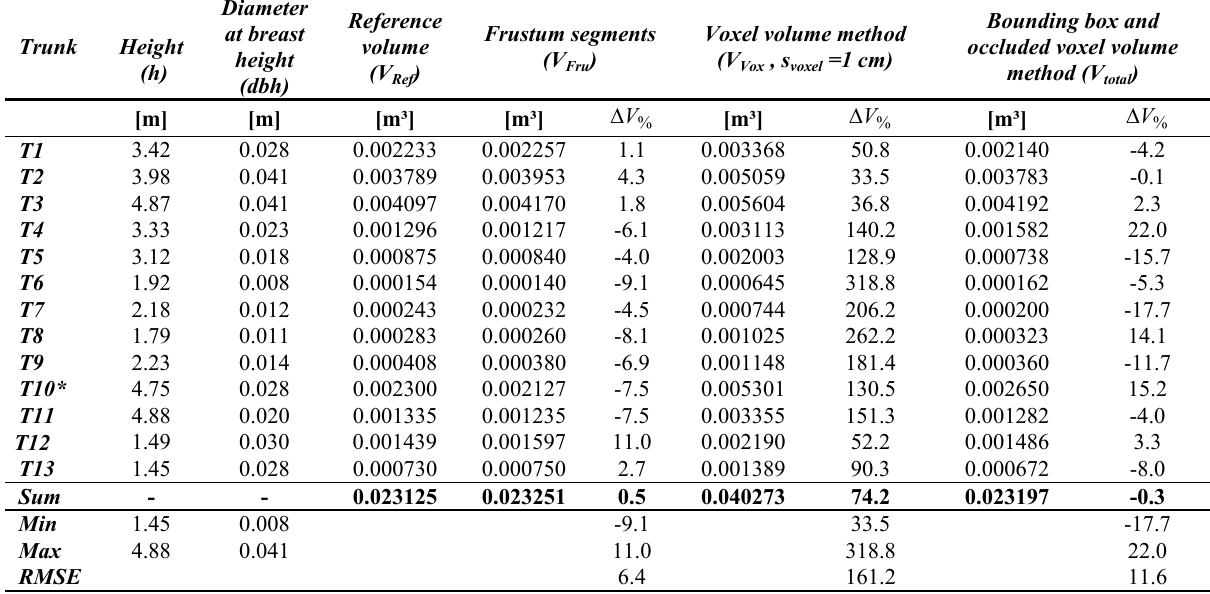
Table 1. Volume determinations of the trunks of data set A via frustum segments ( V Fru ), voxels ( V Vox ) and bounding boxes